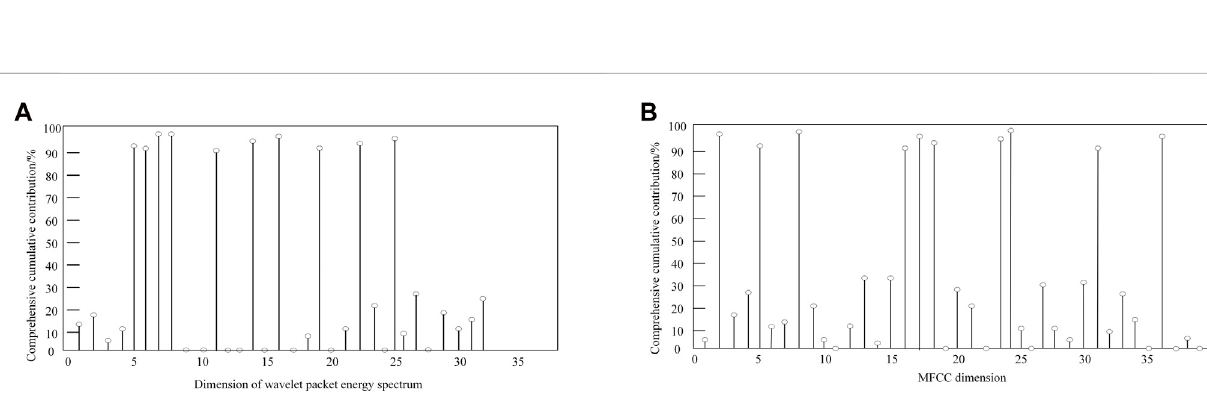
FIGURE 8 Cumulative contribution rate of comprehensive characteristic parameters of weight factor α = 0.2.